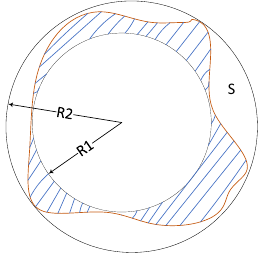
Figure 2. Diagram about non-spherical particle analysis Figure 2 is the scattering cross section of general aerosol particles bounded by the closed surface S. R2 is the minimum sphere radius of the aerosol particles centered at the origin of the coordinate system. R1 is the radius of the concentric sphere